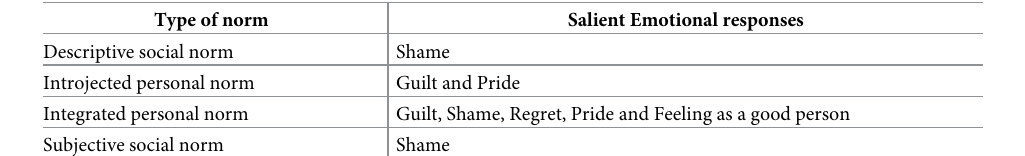
Table 2. Expected emotions by